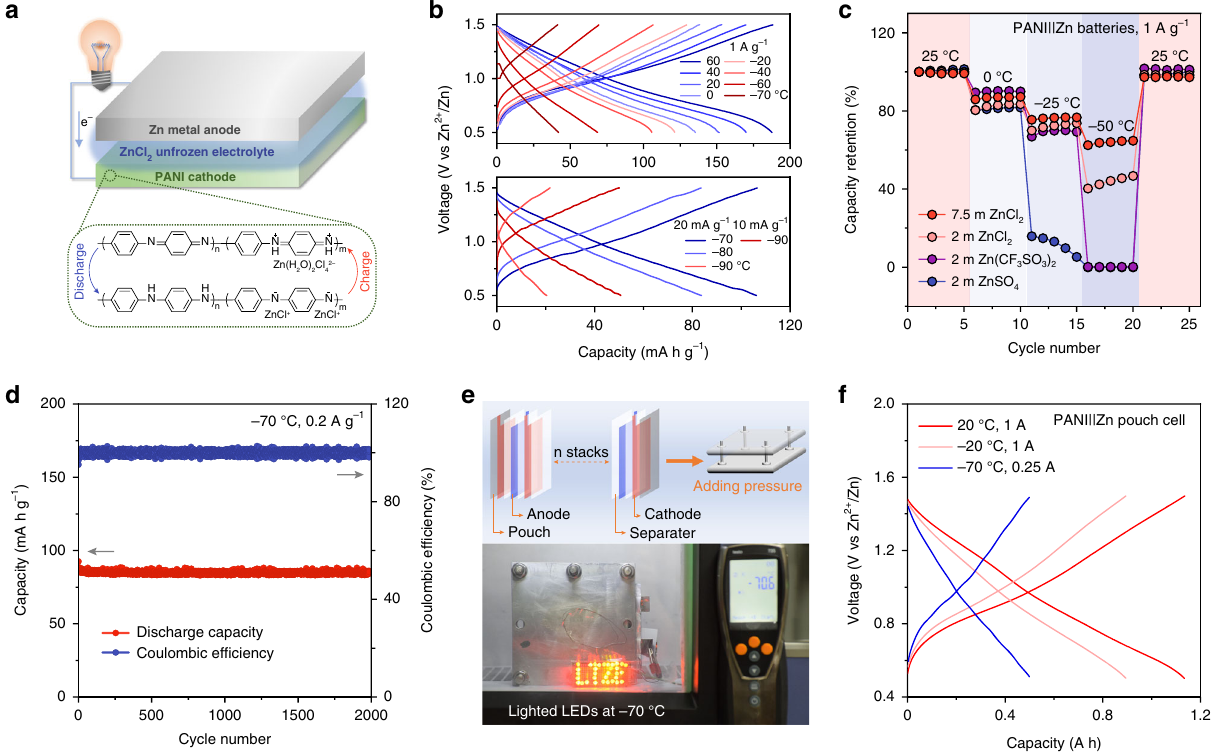
Fig. 5 The energy storage mechanism and performance of PANI|LTE|Zn batteries. a The con fi gurations and redox mechanism of PANI|LTE|Zn batteries. b Discharge – charge curves of PANI|LTE|Zn batteries at the temperature range of – 90~ + 60 °C. c The comparison of batteries using common electrolyte and LTE in varying-temperature performance. d Cycling performance at – 70 °C and 0.2 A g – 1 . e The schematic of assembled pouch cell and the